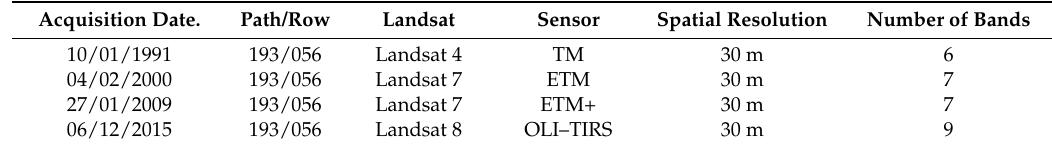
Table 1. Characteristics and properties of the Landsat images used .